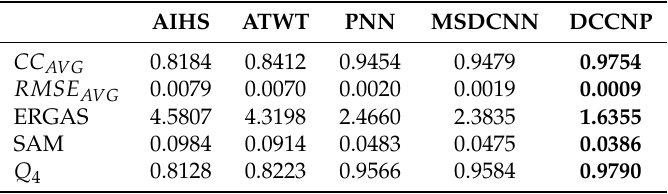
Table 3. Quantitative assessments of IKONOS